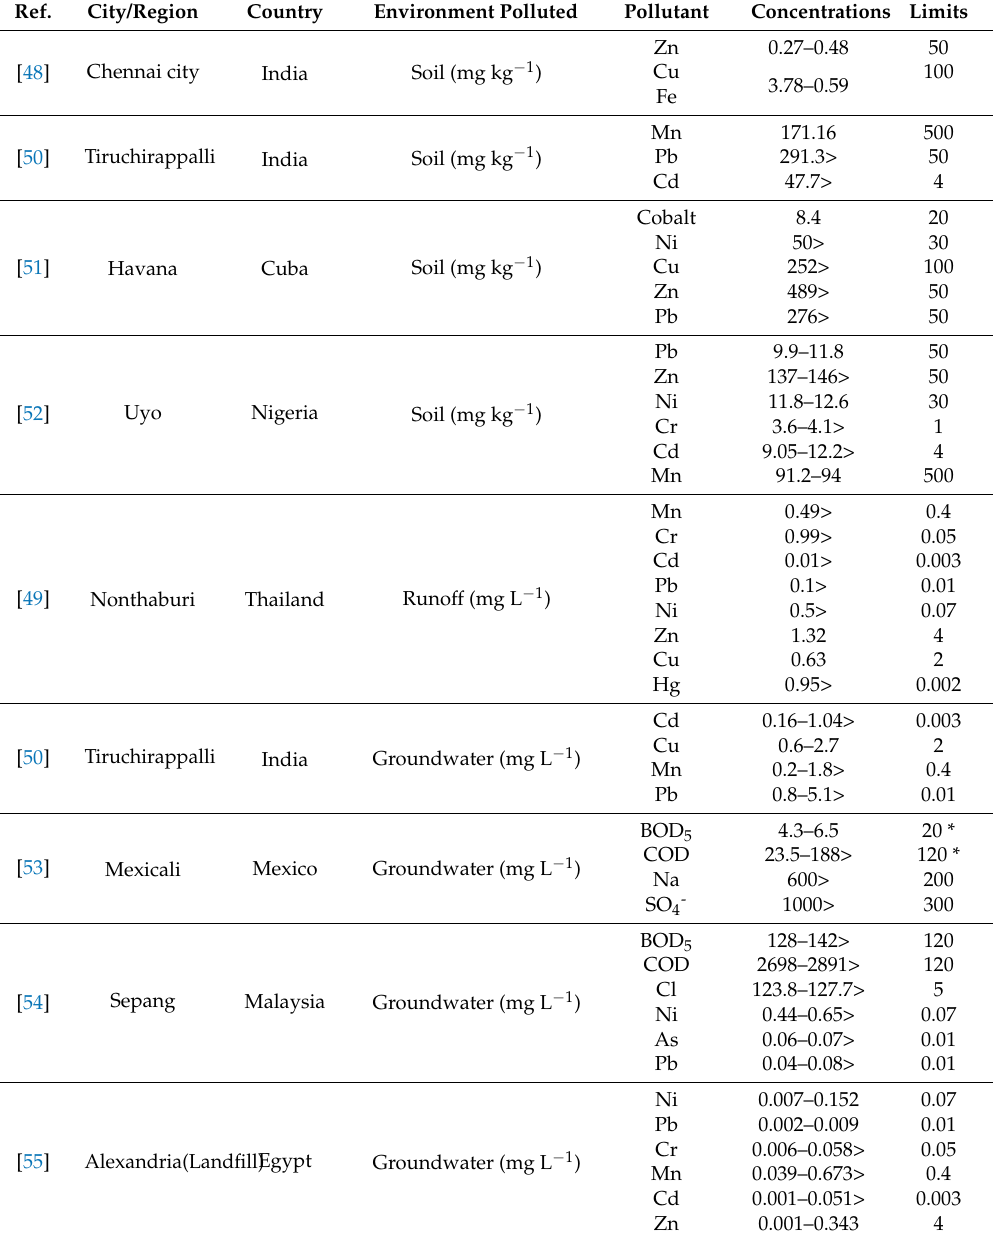
Table 1. Contaminants’ concentration in soil, runoff and groundwater due to open dumping in eight case studies, compared with international standard of soil contamination limits and drinking water.